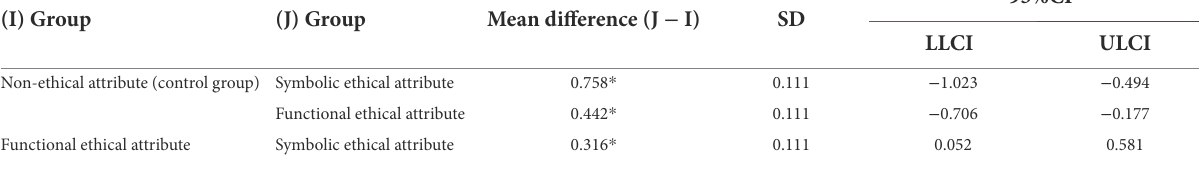
TABLE 3 Test results of consumers’ willingness to buy farmer-assisting agricultural products